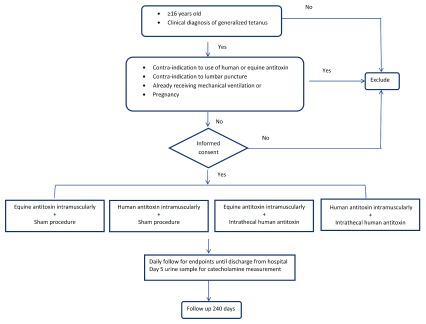
Study flowchart.